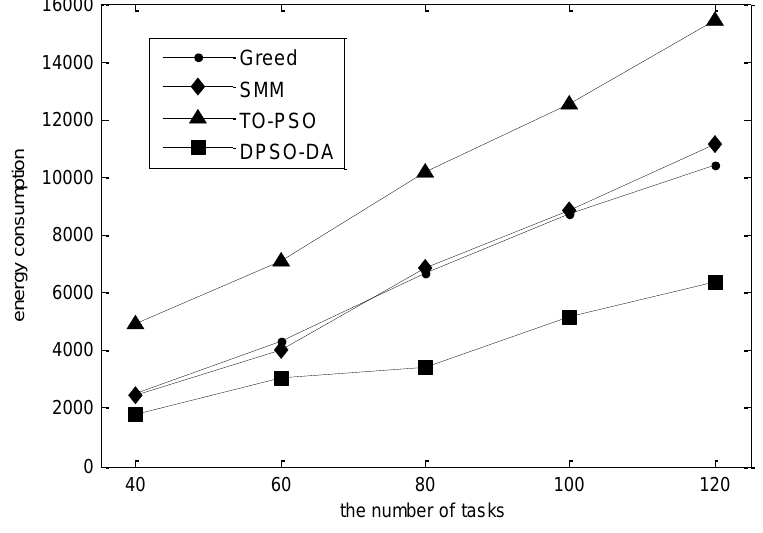
Figure 11. The total energy consumption for the dynamic tasks under different task allocation